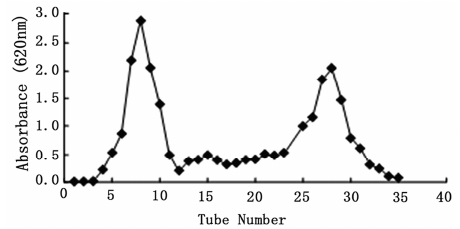
Figure 2. Purification of crude MEP by column chromatography.